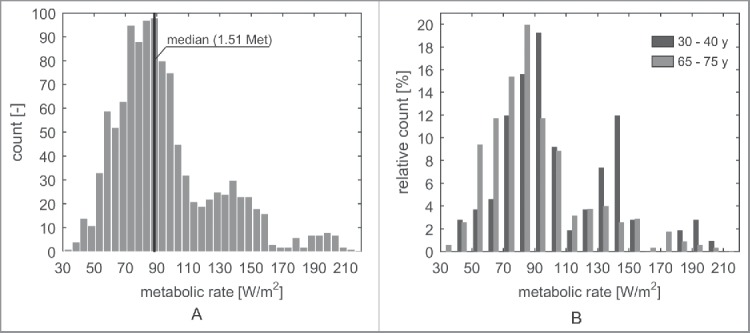
(A) All identified metabolic rates. (B) Identified metabolic rates of adults and elderly. The age groups 30–40 y and 65–75 y were chosen because information on these groups was available from the database of the Dutch central bureau for statistics (CBS) shown in Table 3.